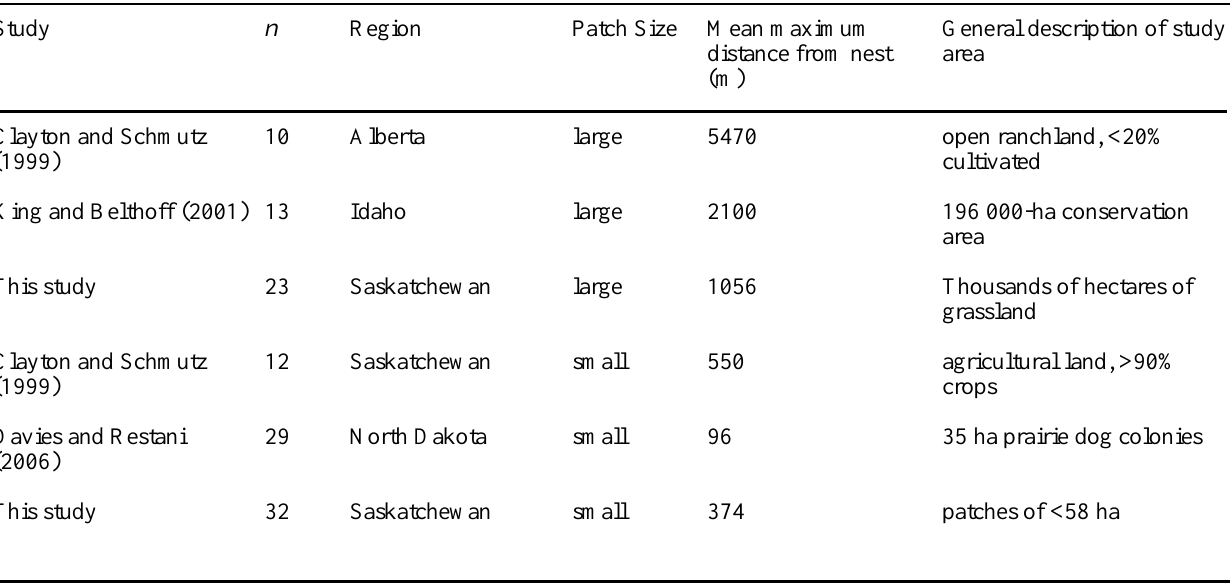
Table 2. A comparison of studies reporting mean maximum distances juvenile Burrowing Owls moved from their nest before